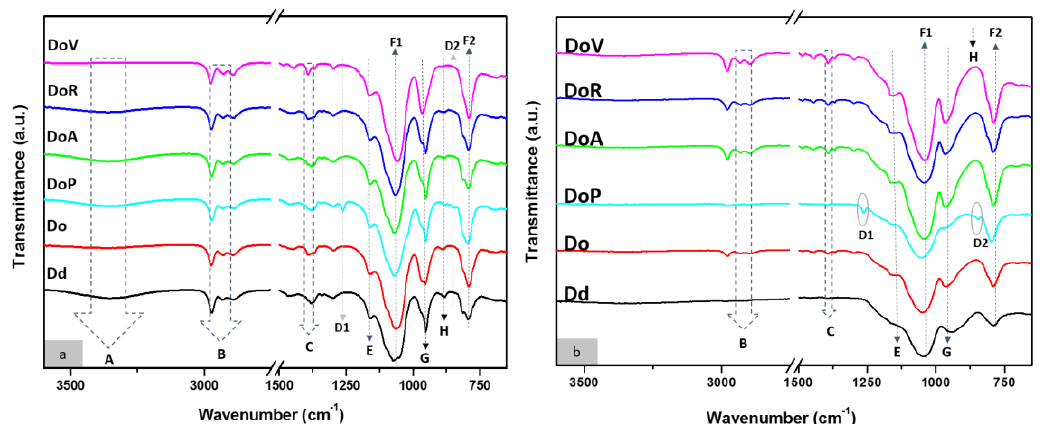
Figure 3. FTIR spectra of sols ( a ) and powders ( b ) of ethylsilicate consolidants with and without particles.